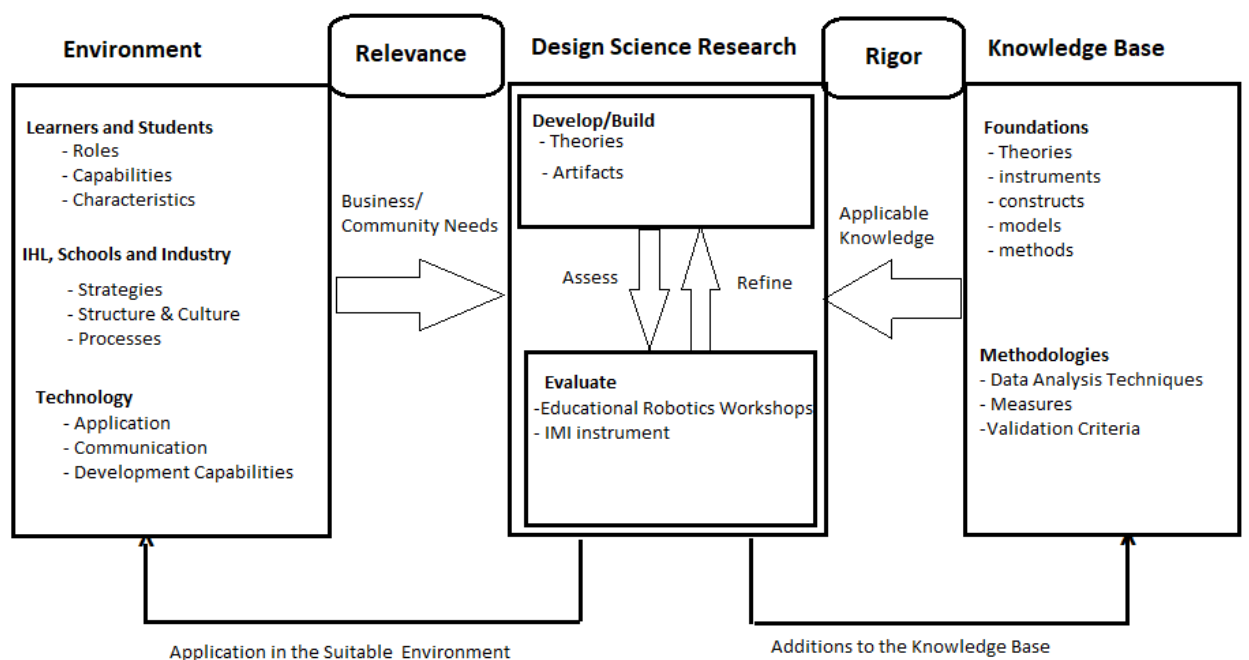
Figure 1. Design Science Research Methodology derived from (Hevner et al., 2004).